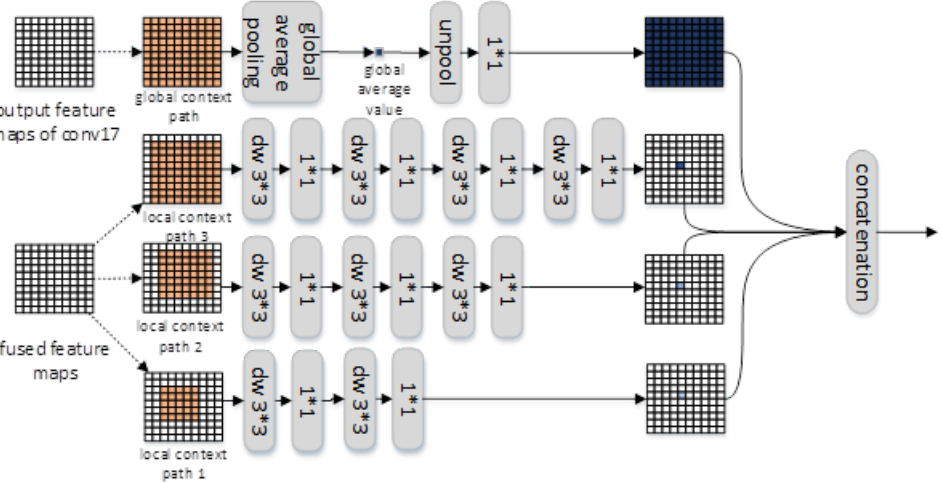
Figure 4. Context incorporation. Depthwise separable convolution (dw for short) is used to reduce computation, each convolutional layer is followed by a batchnorm layer and a ReLU layer.